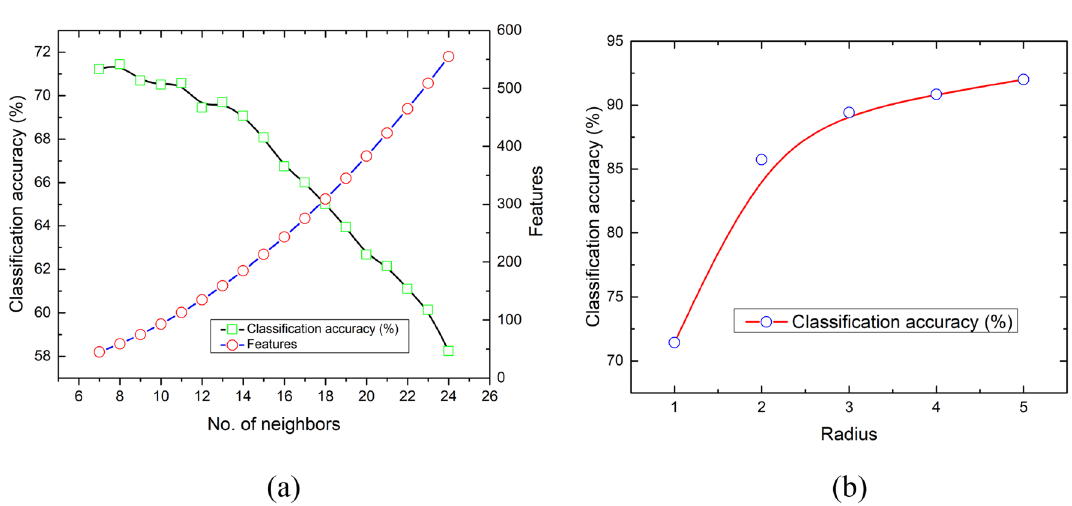
Figure 14. The sensitivity analysis of LBP parameters: ( a ) the number of neighbors, and ( b ) the radius.